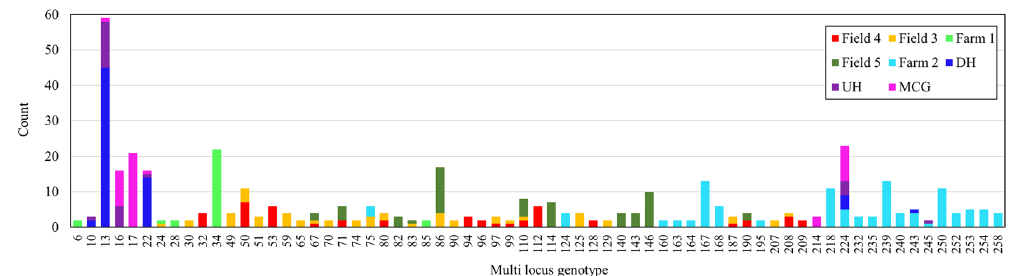
mixed-cropping farms clustered separately (Fig. 4). The Mantel test detected significant association between the genetic and geographical distance of the five C. beticola populations in New York for the entire dataset ( R 2 = 0.60, P = 0.039) but not for the clone-corrected data set ( R 2 = 0.48, P = 0.052) (Fig. 5). Population structure analysis with no a priori population assignment through Bayesian clustering analysis of both the clone-corrected and non-clone-corrected datasets resulted in detection of two distinct clusters in the population (Fig. S2). Likewise, a dendrogram produced based on Bruvo’s distance (Fig. 6) grouped the C. beticola isolates into two major clades. Two hundred and twenty-nine isolates were assigned to cluster 1 and 275 isolates were assigned to the remaining cluster. These two clusters did not correspond to sampling location or